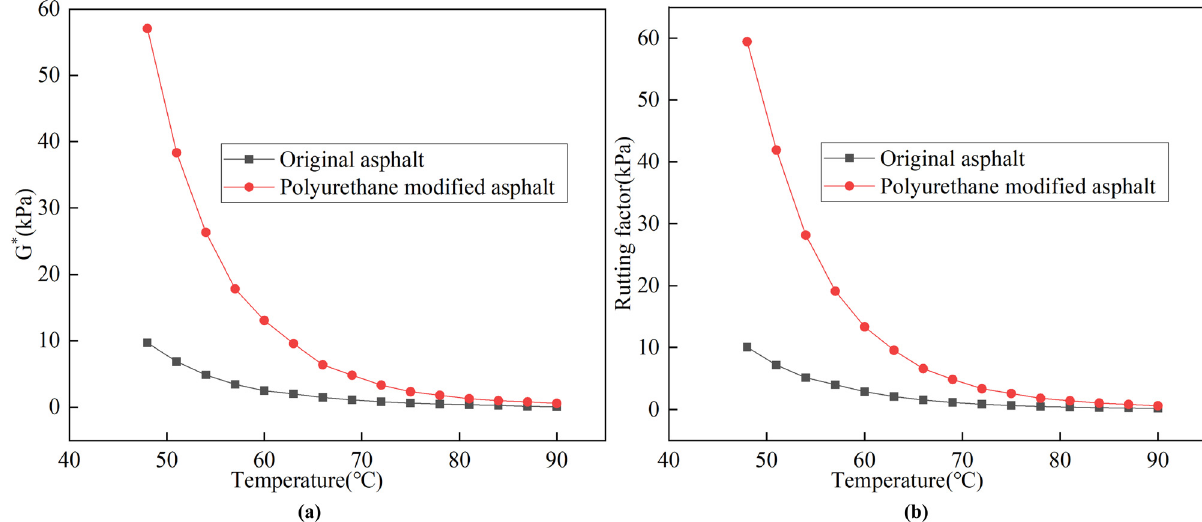
Figure 19: DSR test result of two asphalts: ( a ) complex modulus S and ( b ) rutting